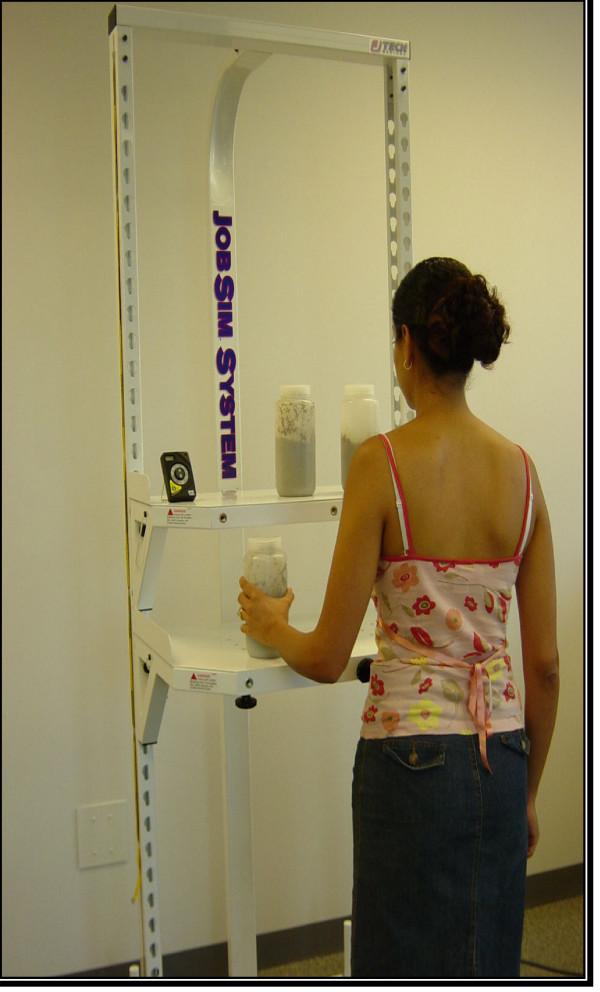
Task 1, "Waist-Up".